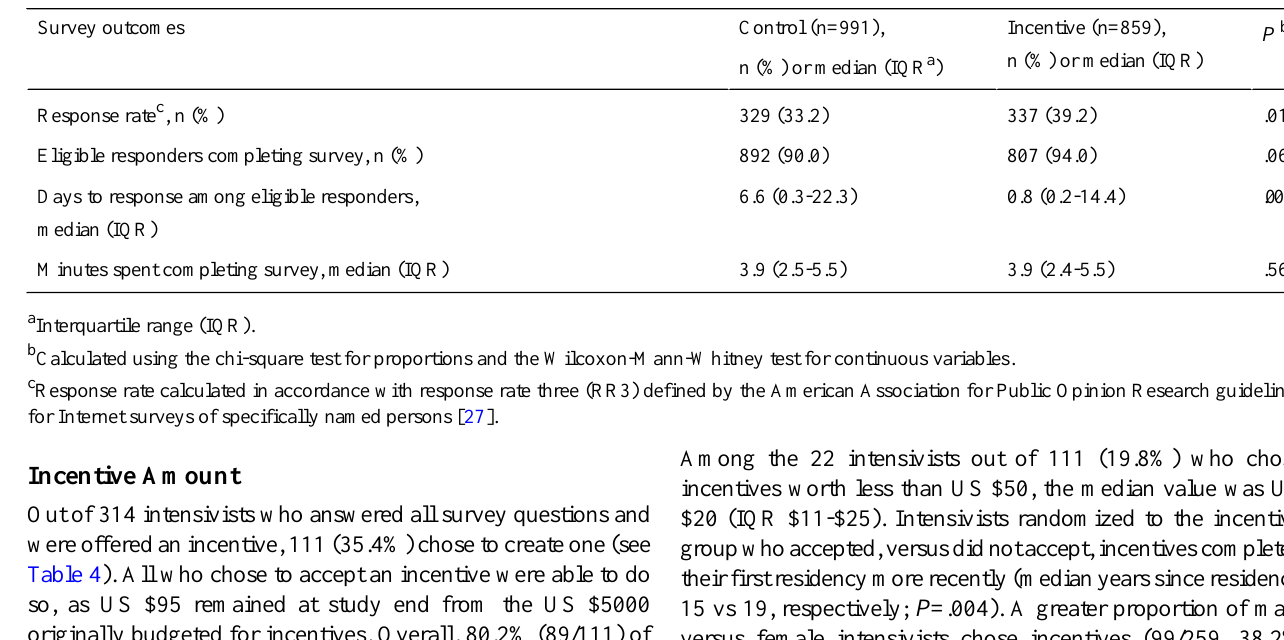
Table 3. Survey outcomes by intervention arm.